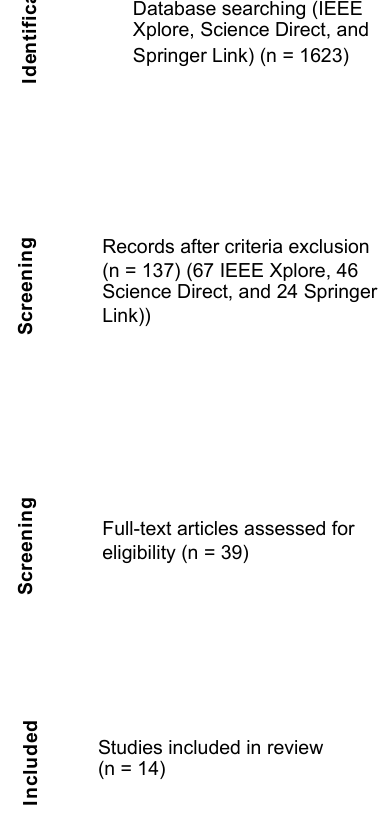
Figure 2. Search strategy flow diagram.